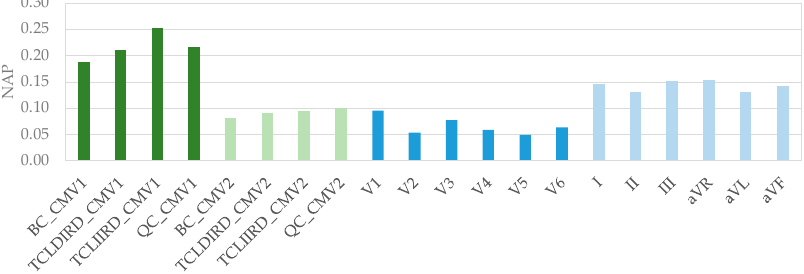
Figure 4. Mean values of NAP for Laplacian estimates via CREs at CMV1 and CMV2 and those for standard 12-lead ECG signals.